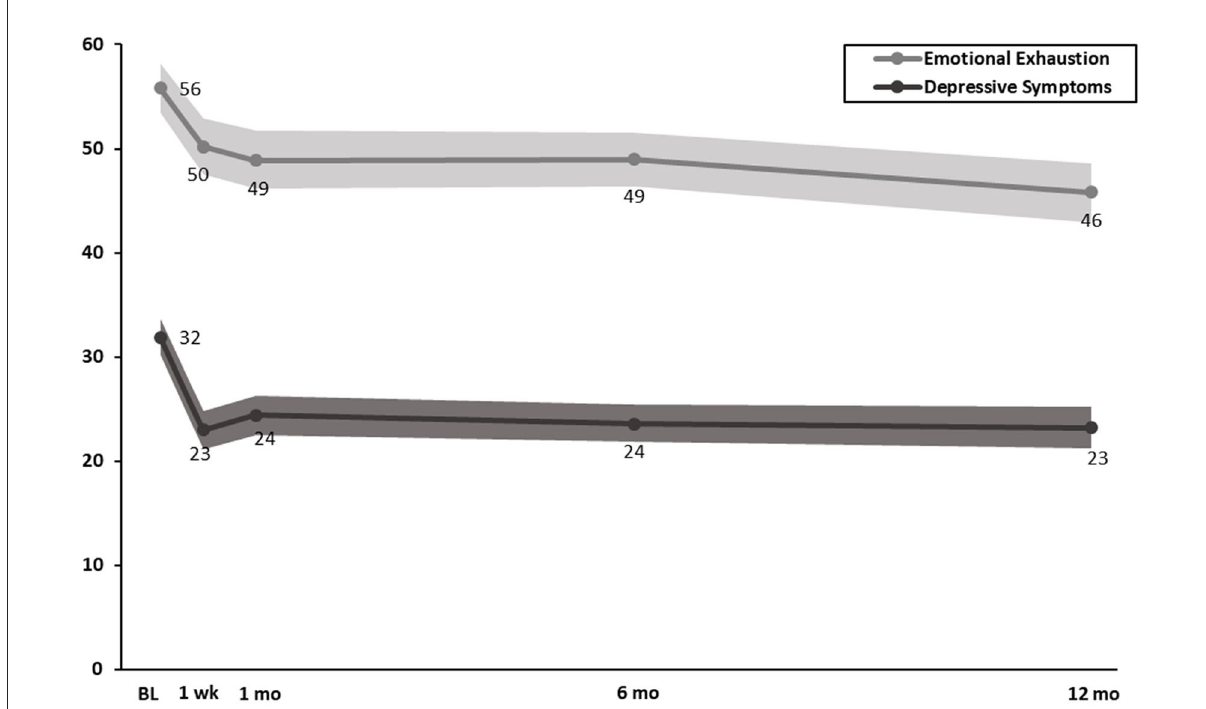
FIGURE2 Effect of WISER for emotional exhaustion and depressive symptoms at 1-week, 1-, 6-, and 12-month post-intervention (100-point scale). Dots in the middle line: point estimates from mixed-effects models for each time point; shaded areas: 95% confidence intervals from mixed-effects models. BL, baseline; 1 wk, 1-week post-intervention; 1 mo, 1-month post-intervention; 6 mo, 6-month post-intervention; 12 mo, 12-month